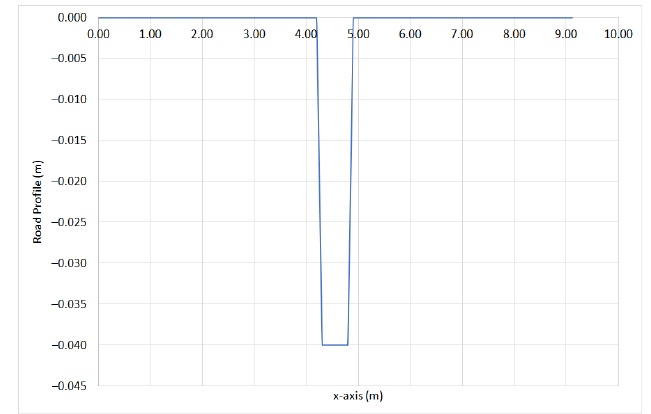
Figure 6. The pothole excitation.